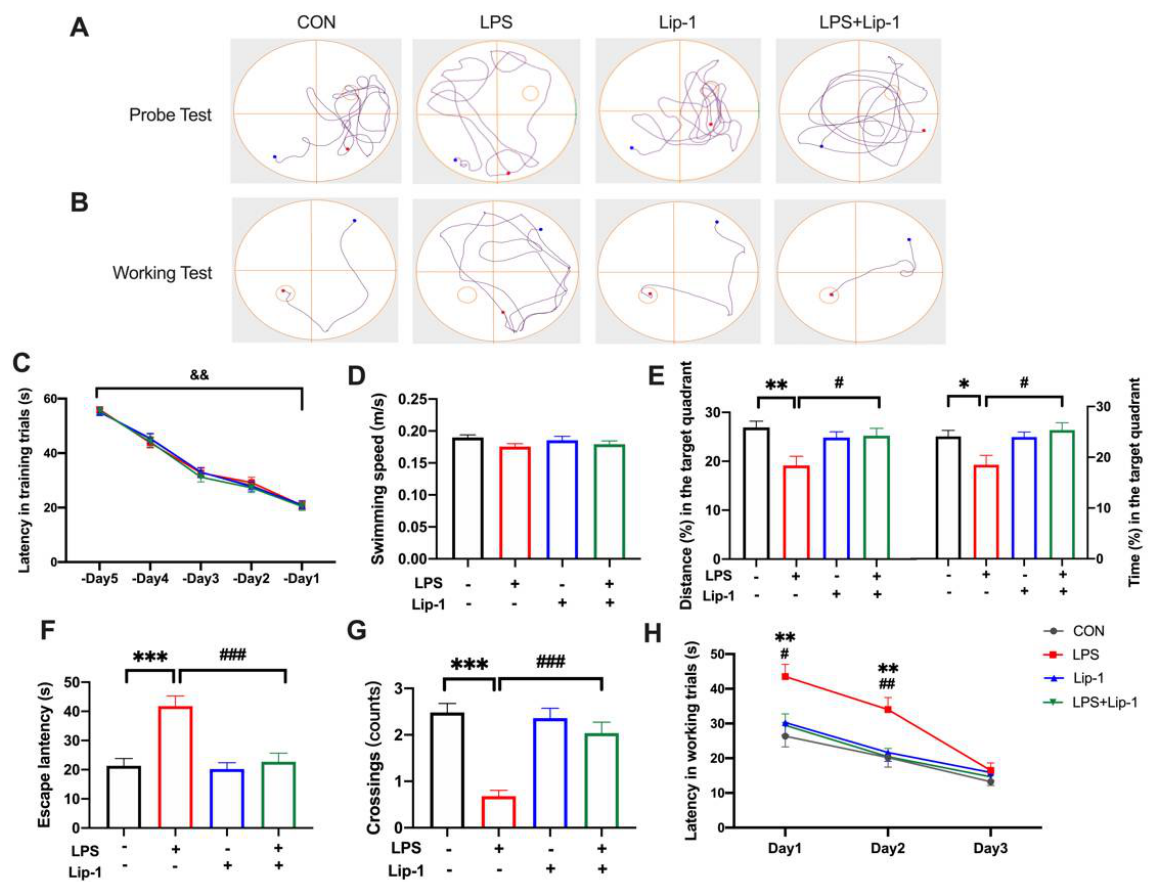
Figure 2. Liproxstatin-1 attenuated behavioral performance in MWM test after exposure to LPS in mice. After five consecutive days of acquisition phase in MWM test, the mice received LPS (or aCSF) microinjection. ( A ) Representative trajectories of mice in four groups in the probe test. The small circle presents the site of platform, which was removed during the probe test. ( B ) Representative trajectories of mice to the new platform in spatial working memory test, in which the hidden plat- form was randomly changed to another quadrant (the third quadrant in this representative trajec- tory). ( C ) Latency to the platform over the five training days. ( D ) Swimming speed, ( E ) the percent- age of distance and time at the platform-site quadrant, ( F ) latency to the platform, ( G ) platform-site crossings during the probe test. ( H ) Latency to the new platform during spatial working memory test on Day 1, 2, and 3 after LPS treatment. Data are expressed as mean ± SE ( n = 25 for probe test and n = 17 for working memory test). * p < 0.05, ** p < 0.01, *** p < 0.001 vs. CON group; # p < 0.05, ##